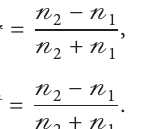
maximize the light transmittance. According to the study by Powell et al. [12], the electrical efficiency of PV modules with silicon encapsulant was improved by 0.31–1.45% compared to that of modules with conventional ethylene vinyl acetate (EVA). This result indicates that the use of optically superior silicone encapsulant materials is helpful for PV module energy